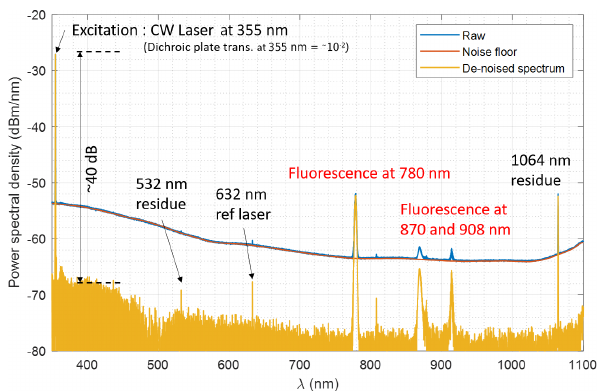
Figure 4. The 1000µm diameter, 2m long fiber fluorescence mea- surement with 355nm laser illumination.